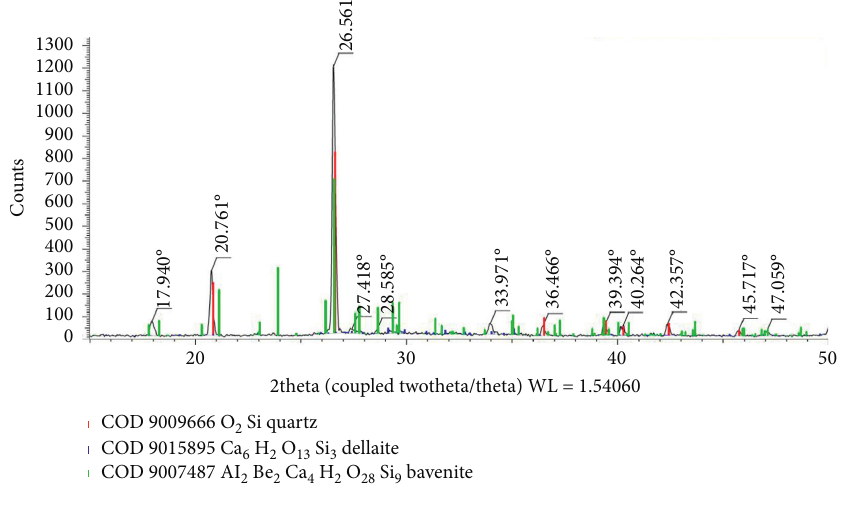
Figure 10: XRD diffractogram for PPC (H